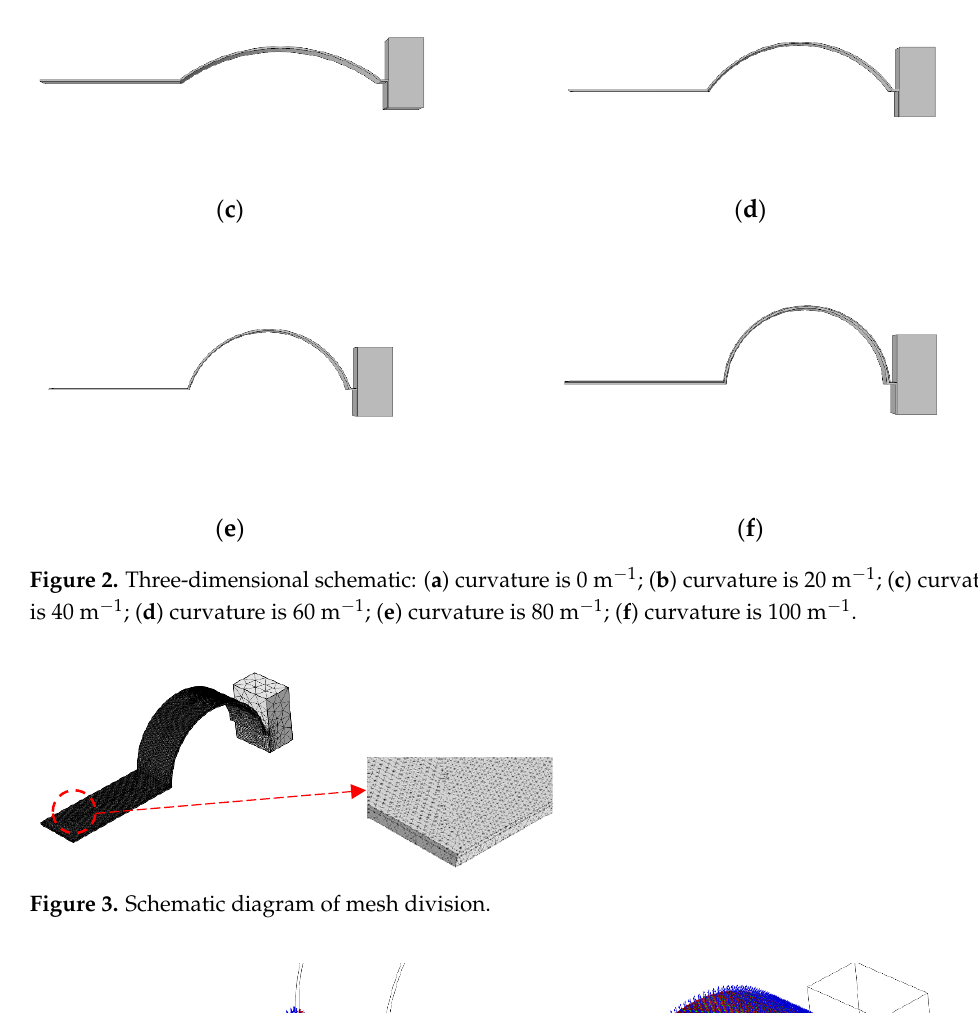
Figure 3. Schematic diagram of mesh division.